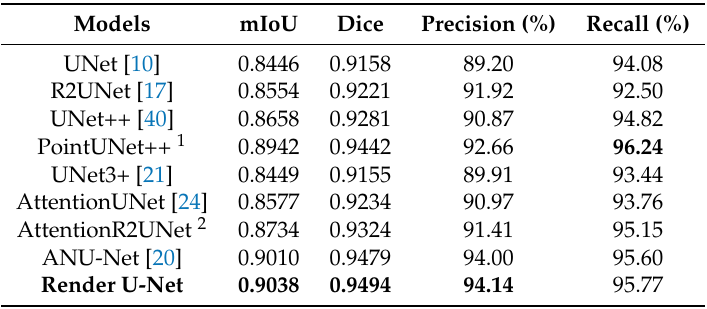
Table 5. Performance of kidney segmentation for MRI images.